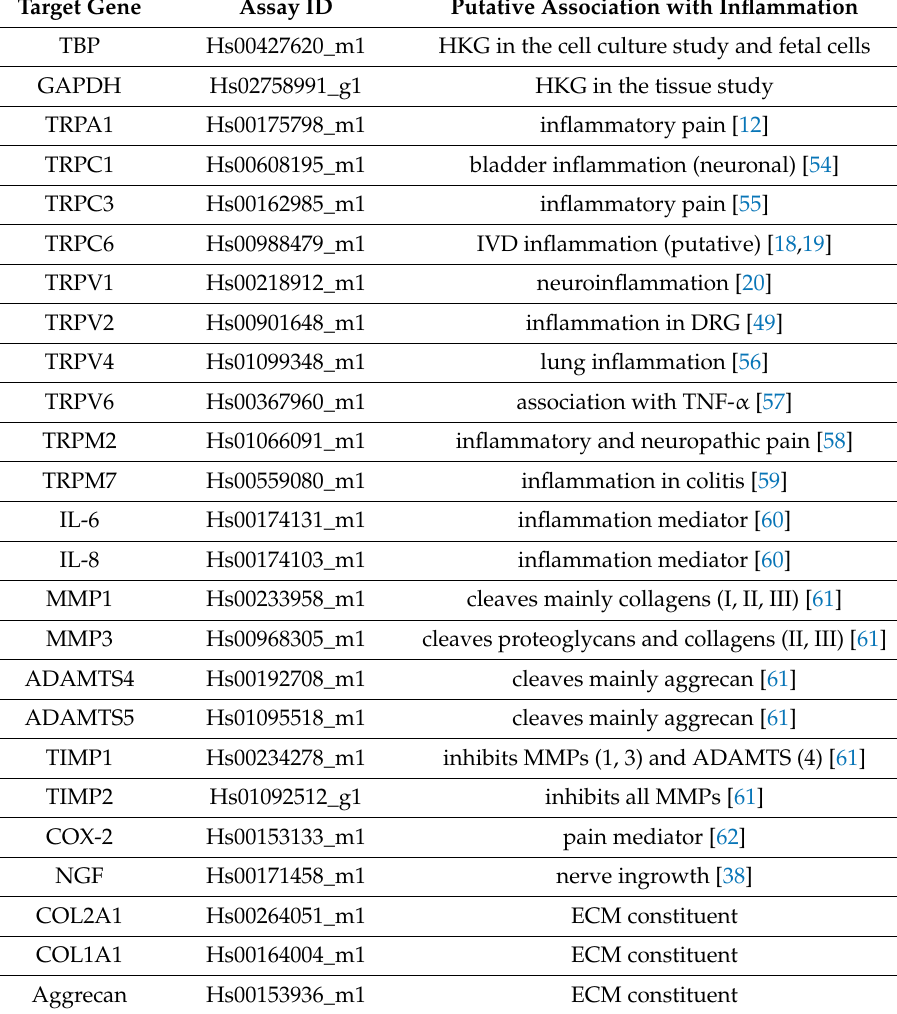
Table 6. Target genes and assay identification (ID) numbers of corresponding TaqMan primers (TaqMan Gene Expression Assays; Thermo Fisher Scientific). TRP = transient